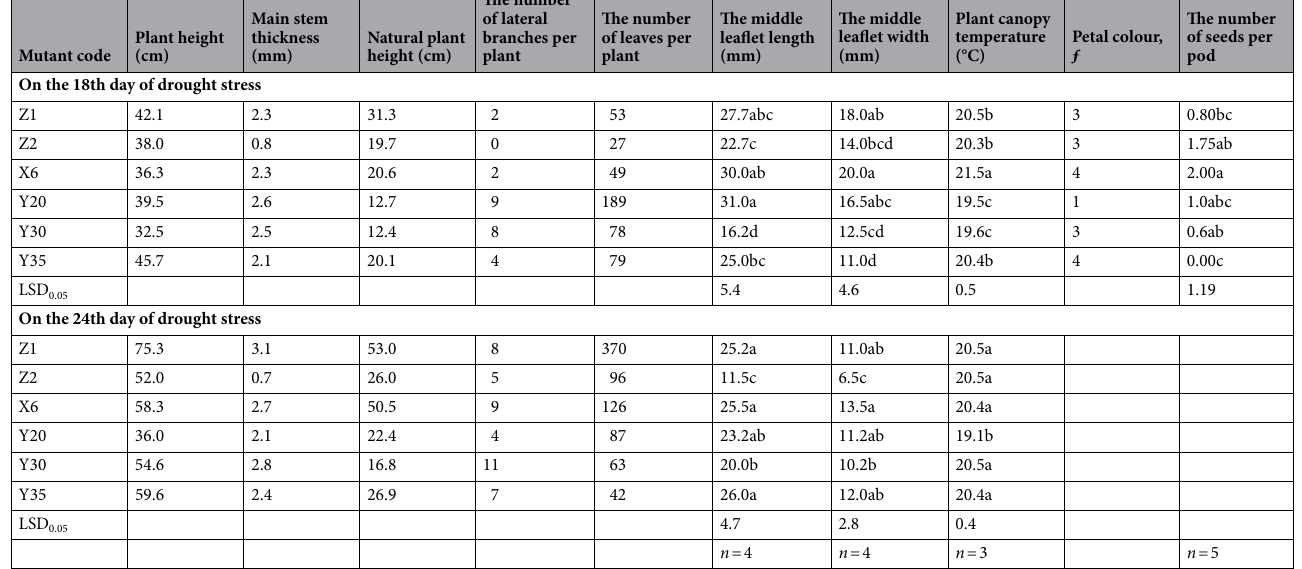
Table 1. Agro-morphological parameters determined on the 18th and 24th days of drought stress applied after first cutting at budding stage. ƒ 1, light pink; 2, pink; 3, light purple; 4, purple. Different letters indicate significant differences at P < 0.05 .